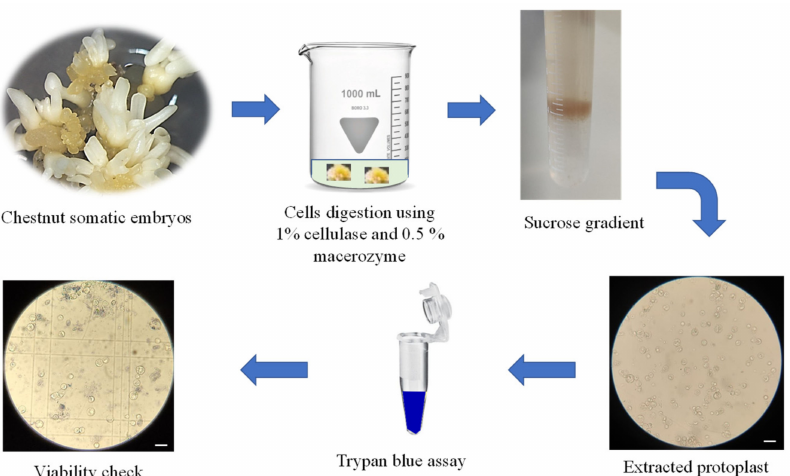
Figure 4. Chestnut protoplast isolation protocol starting from embryogenic callus derived from somatic embryos. Scale bar = 100 µ